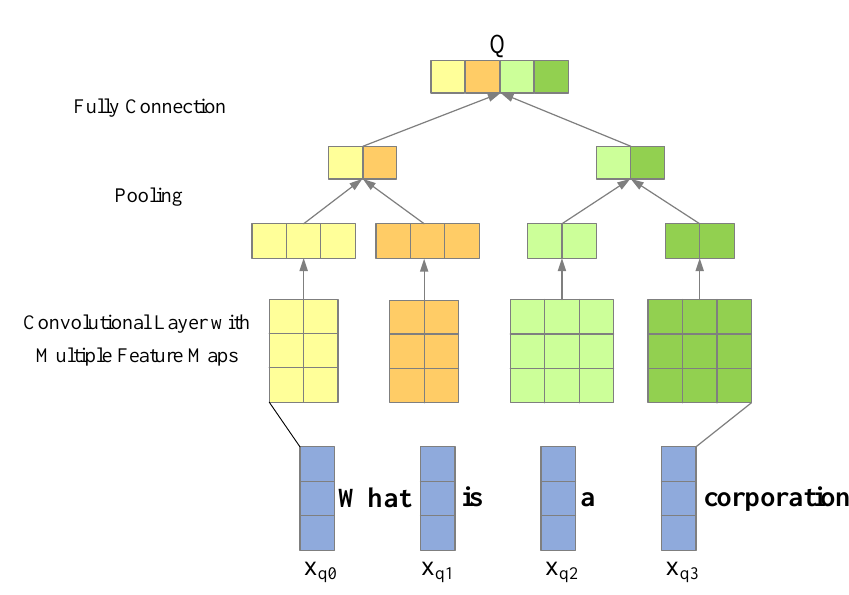
Figure 9. Using CNNs to extract features of